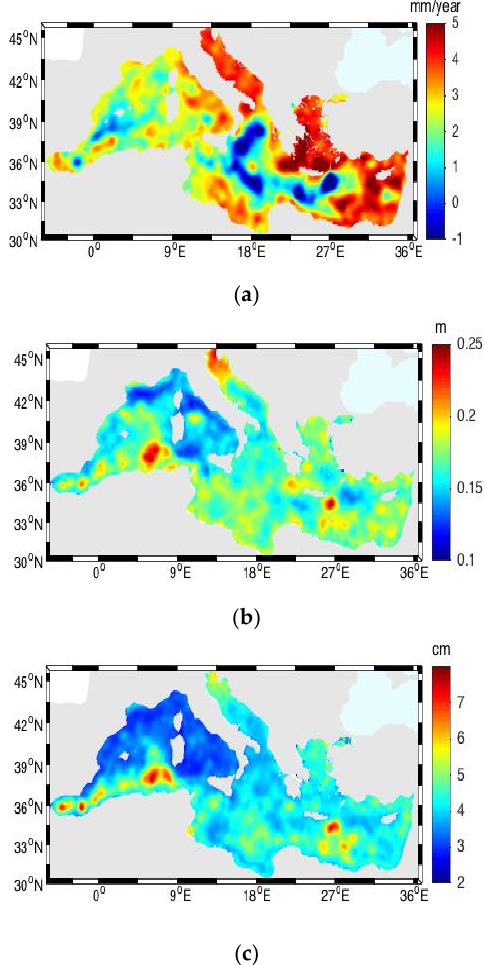
Figure 10. Sea level anomalies (SLA): ( a ) multiyear trends; ( b ) mean annual 99th percentiles; ( c ) standard deviation in SLA. Maps are based on data from 1 January 1993 to 31 December